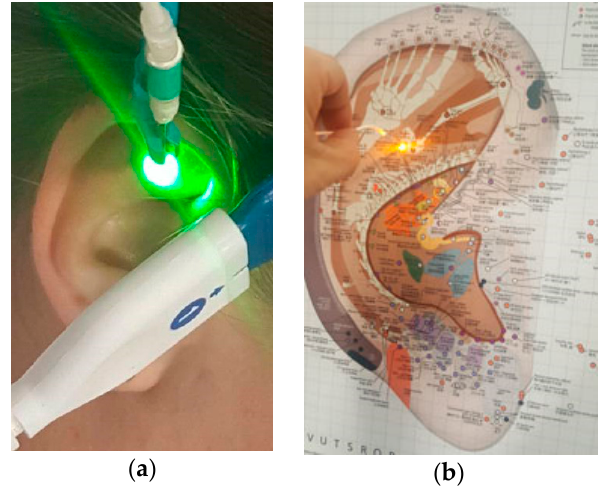
Figure 1. Green ( a ) and yellow ( b ) ear acupuncture laser at the ear point Shenmen. Acupuncture with a green laser (e.g., 532 nm) has so far not found a broad field of